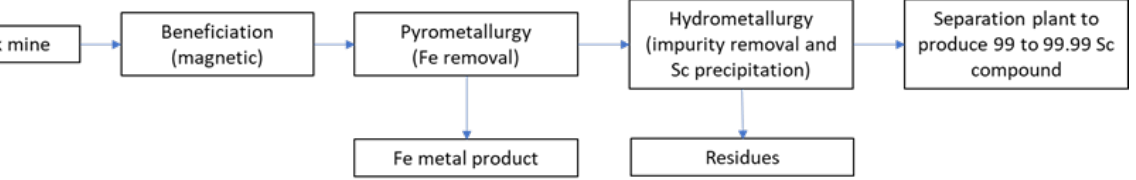
Figure 1. Proposed processing scheme for the Kiviniemi ferrodiorite deposit.